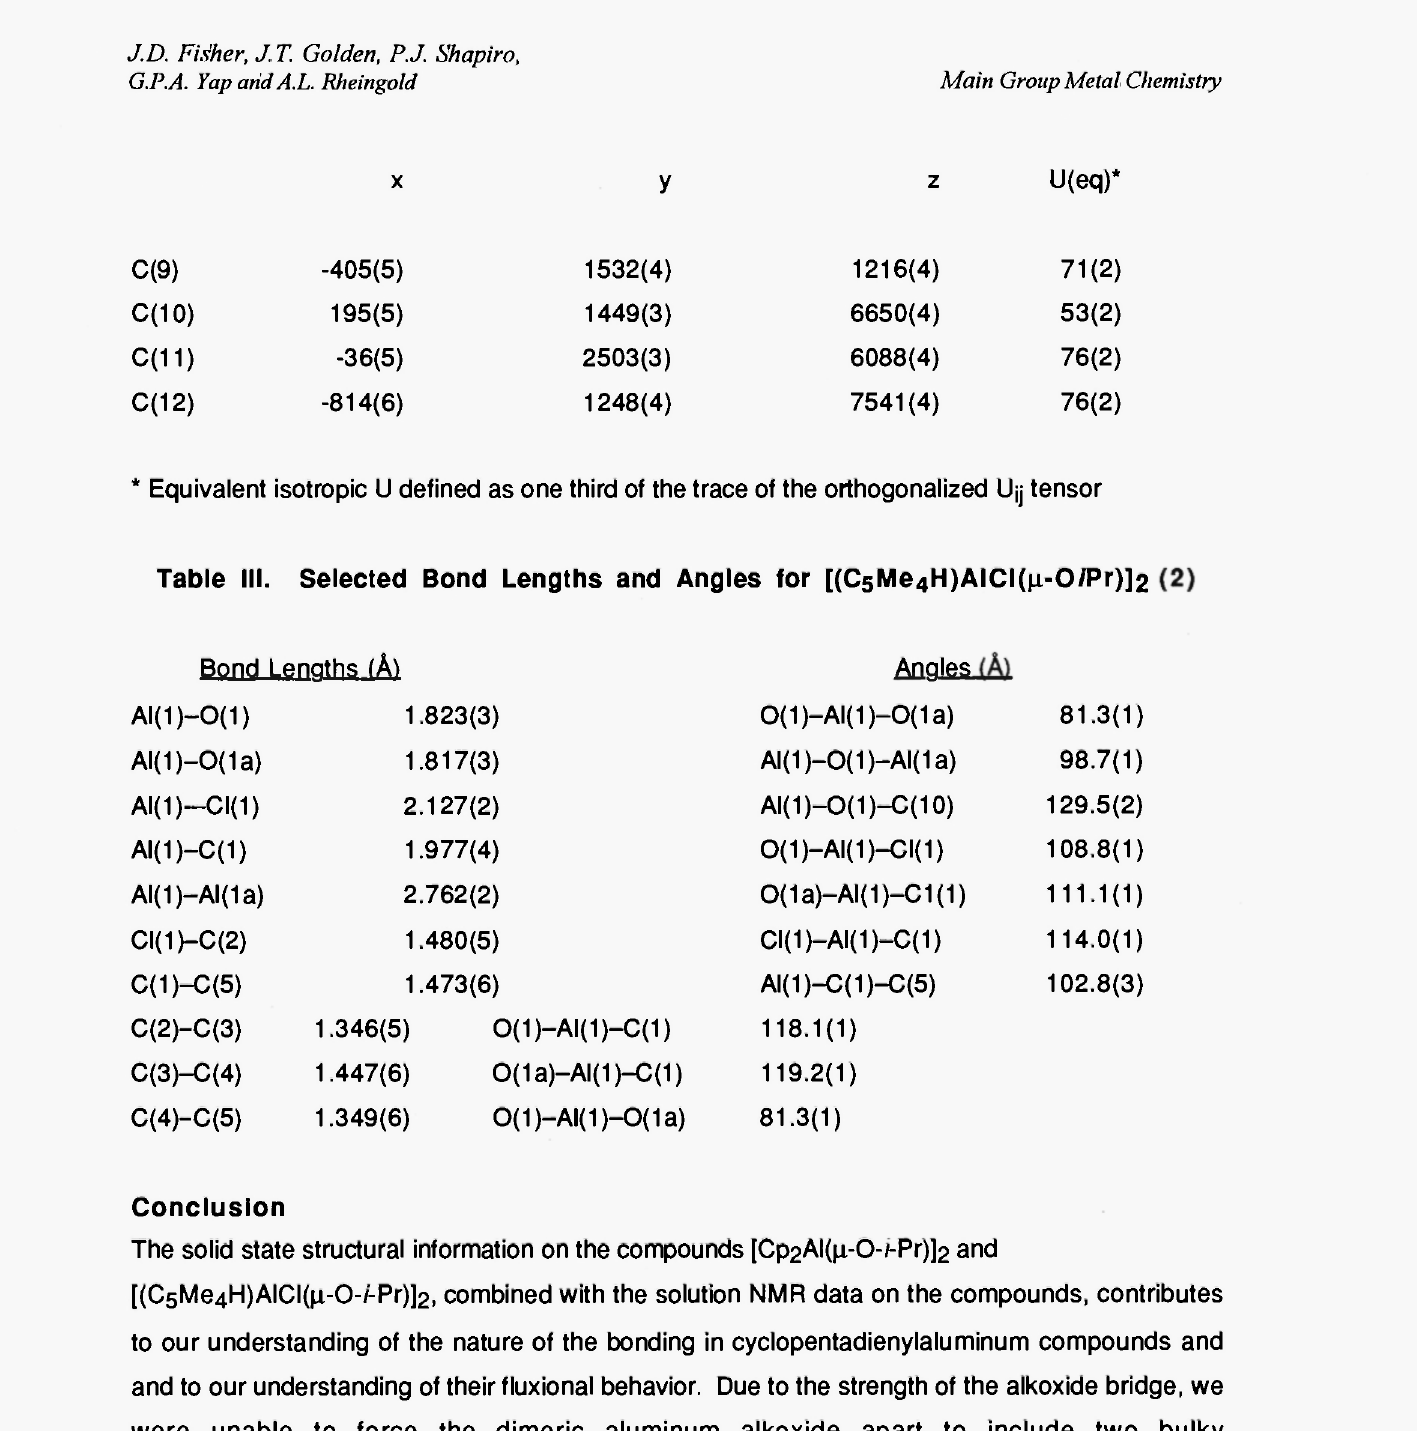
* Equivalent isotropic U defined as one third of the trace of the orthogonalized Ujj tensor